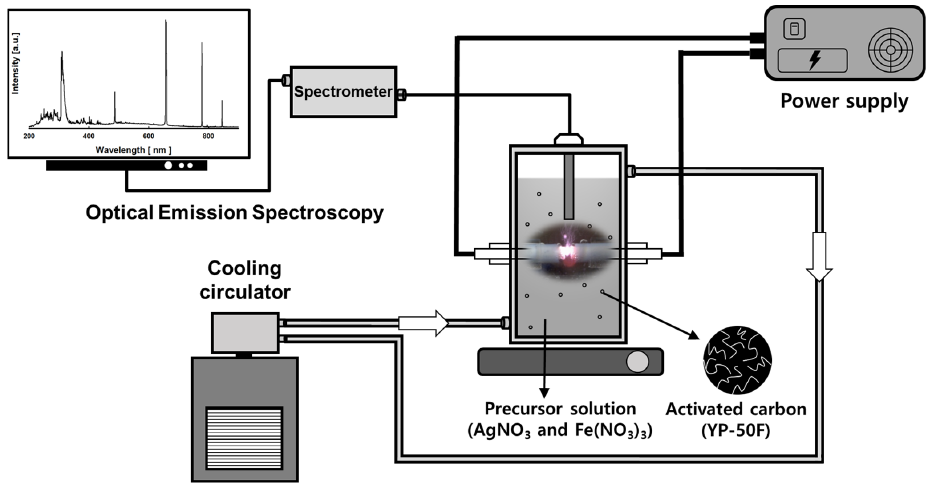
Figure 1. Diagram of the PLP reaction device for preparing Ag/Fe bimetallic nanoparticles supported on activated carbon composites.